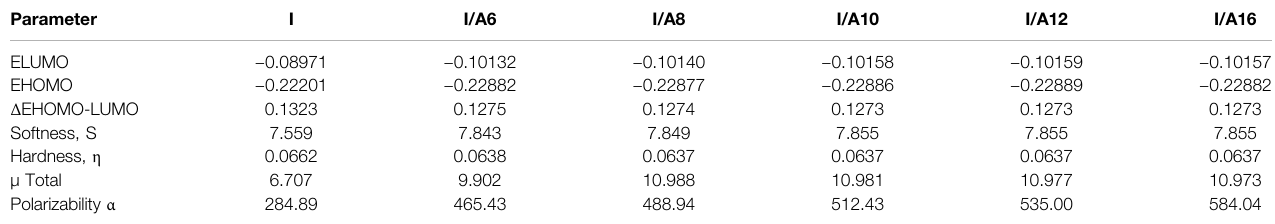
TABLE 4 | FMO Energies a.u., Polarizability, α , and Dipole Moment μ (Debye) of the cyano compound I and its SMHBCs, I/An. Parameter